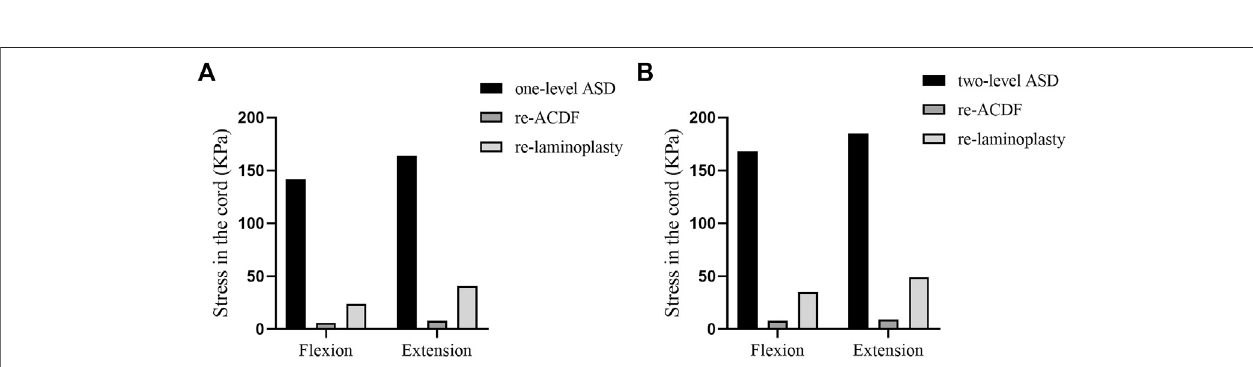
FIGURE7| Maximumvon-Misesstressinthecordofre-ACDFandre-laminoplastymodels. (A) Stressinthecord ofdifferentrevisionsurgeriesforthetreatmentof one-level ASD. (B) Stress in the cord of different revision surgeries for the treatment of two-level ASD.